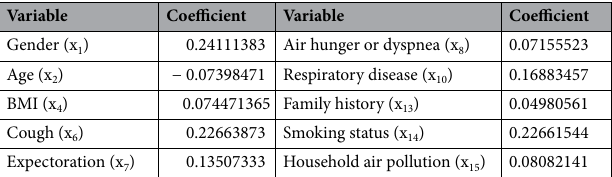
Table 1. Selected variables and their regression